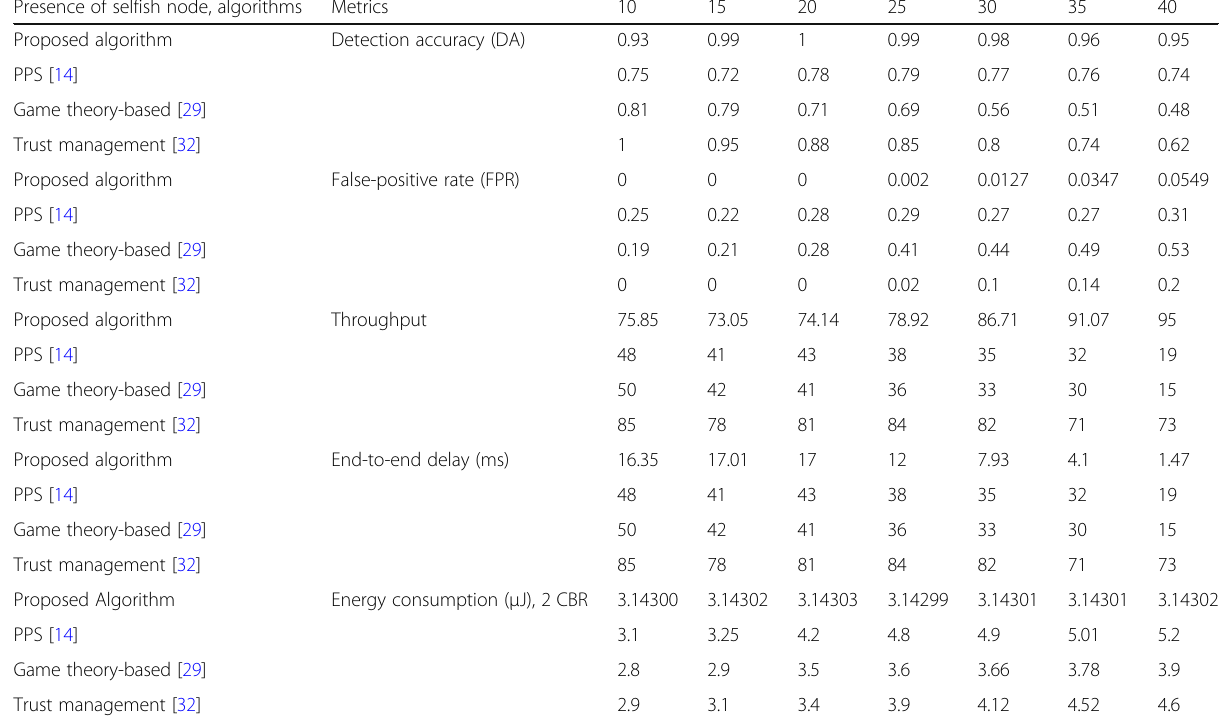
Table 3 Different metrics of the proposed methods in comparison with other methods